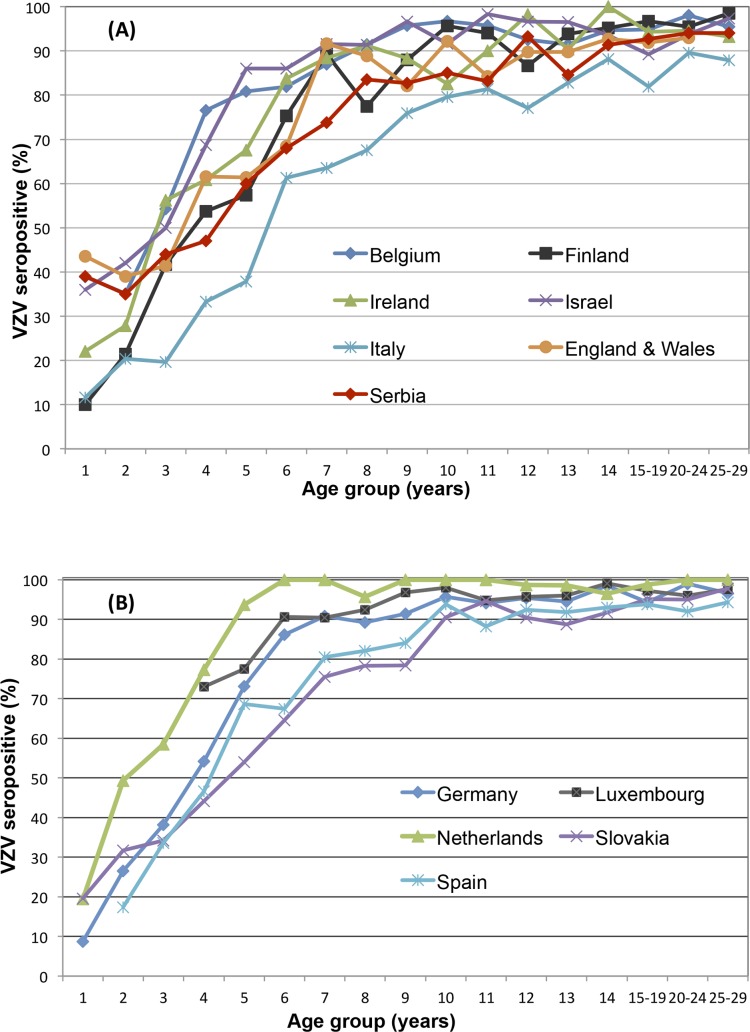
Age-specific (<30 years) standardized seroprevalence of VZV in Vojvodina, Serbia (2015–16), and in 11 ESEN2 countries where samples had been collected either from residual sera (A), or from population sampling (B), 1995–2003. The figure is similar but not identical to the original image from [10], and is therefore for illustrative purposes only.